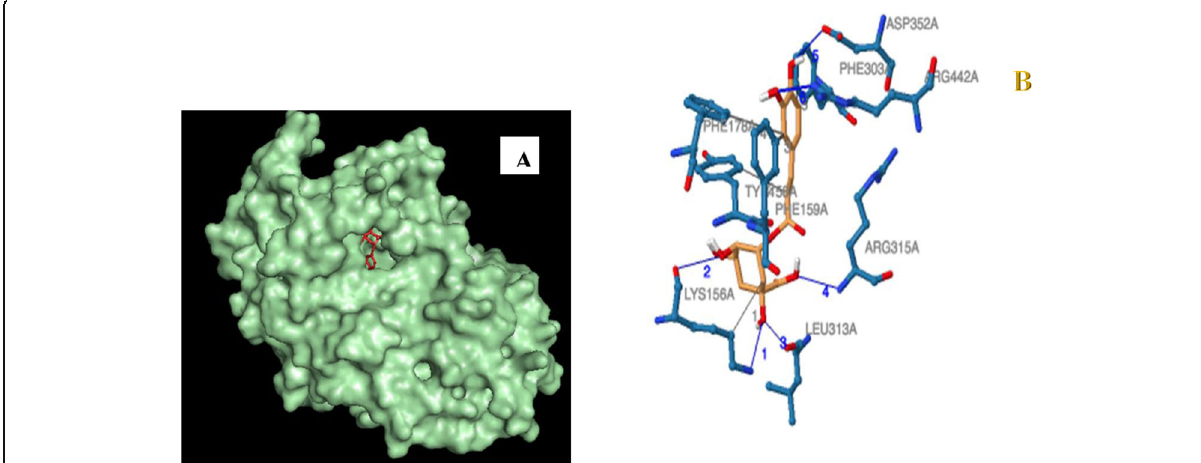
Fig. 2 Binding pose and binding site of chlorogenic acid with α -glucosidase (panel A), molecular interaction of chlorogenic acid with amino acid residues within the binding pocket of the protein structure (panel